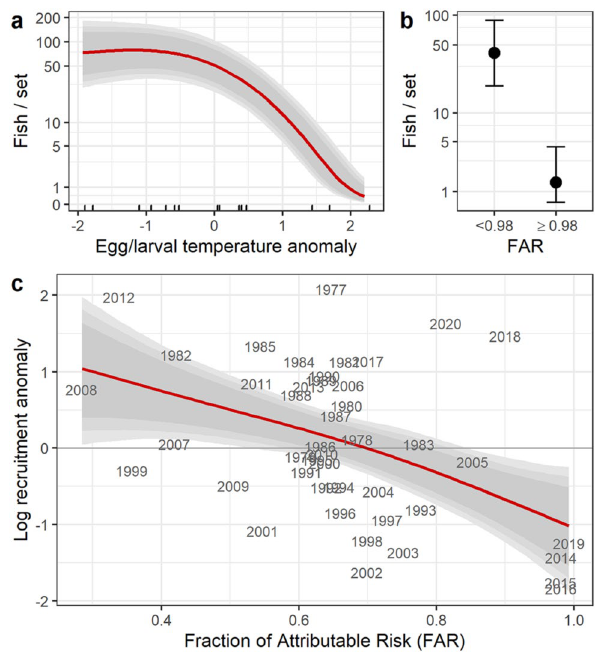
Figure 2. Anthropogenic temperature extremes and Pacific cod recruitment. ( a ) Age-0 recruitment from beach seine data as a function of egg/larval temperature. Grey ribbons indicate 80%/90%/95% CI. ( b ) Age-0 recruitment from beach seine data as a function of the Fraction of Attributable Risk (FAR) for Gulf of Alaska SST anomalies (error bars = 95% CI). ( c ) Estimated cod recruitment from stock assessment model (1977–2016; 2017–2020 values derived from beach seines) as a function of FAR: predicted values and 80%/90%/95% CI. Recruitment log-transformed and scaled as zero mean, unit variance.